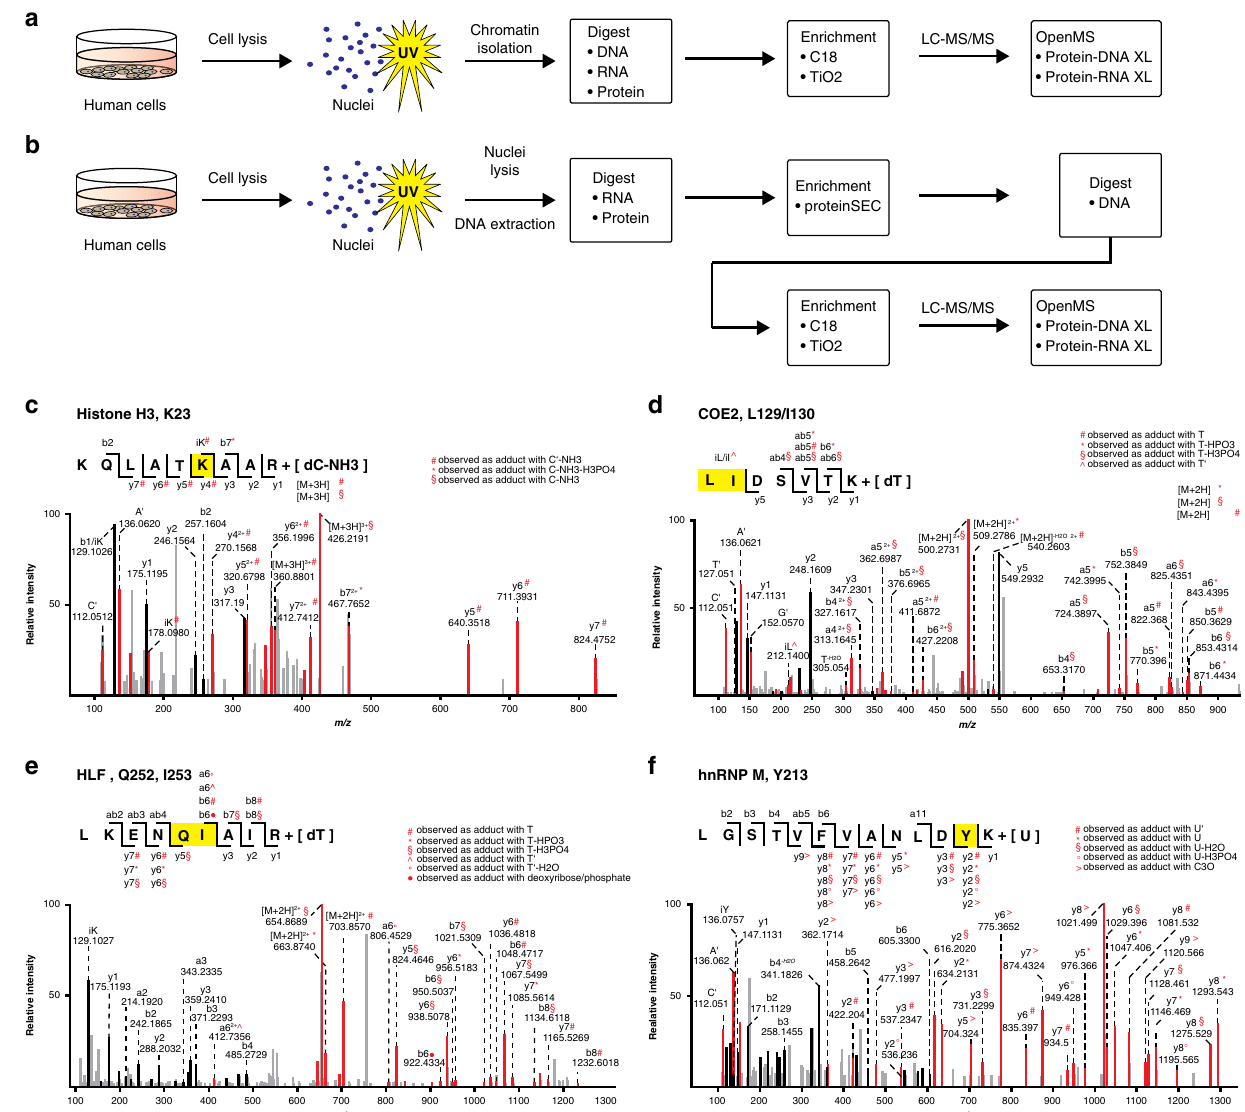
Fig. 4 DNA-protein and RNA-protein cross-links in human cells. a Cross-linking work fl ow for human nuclei. Nuclei are isolated by hypotonic lysis, UV- irradiated and isolated chromatin is subjected to MS-sample preparation and cross-link analysis in OpenMS. b Cross-linking work fl ow for human nuclei with advanced cross-link enrichment strategy. Nuclei are isolated by NP-40 based lysis, UV-irradiated and genomic DNA is isolated using the DNAzol ® Reagent. RNA and proteins are sequentially digested and the DNA-peptide mixture is separated by protein size-exclusion chromatography (proteinSEC). DNA-associated peptides are subjected to DNA digest, C18 and TiO2 enrichment, LC-MS/MS and cross-link analysis in OpenMS. c MS/MS spectrum of an H3 peptide cross-linked to deoxycytidine monophosphate (dC). d MS/MS spectrum of an COE2 peptide cross-linked to deoxythymidine monophosphate (dT). e MS/MS spectrum of a HLF peptide cross-linked to dT. f MS/MS spectrum of a HNRPM peptide cross-linked to uridine monophosphate (U). In each spectrum, the identi fi ed peptide sequence is shown and the cross-linked amino acid is highlighted in yellow. Black: fragment ions; Red: shifted ion fragments and marker